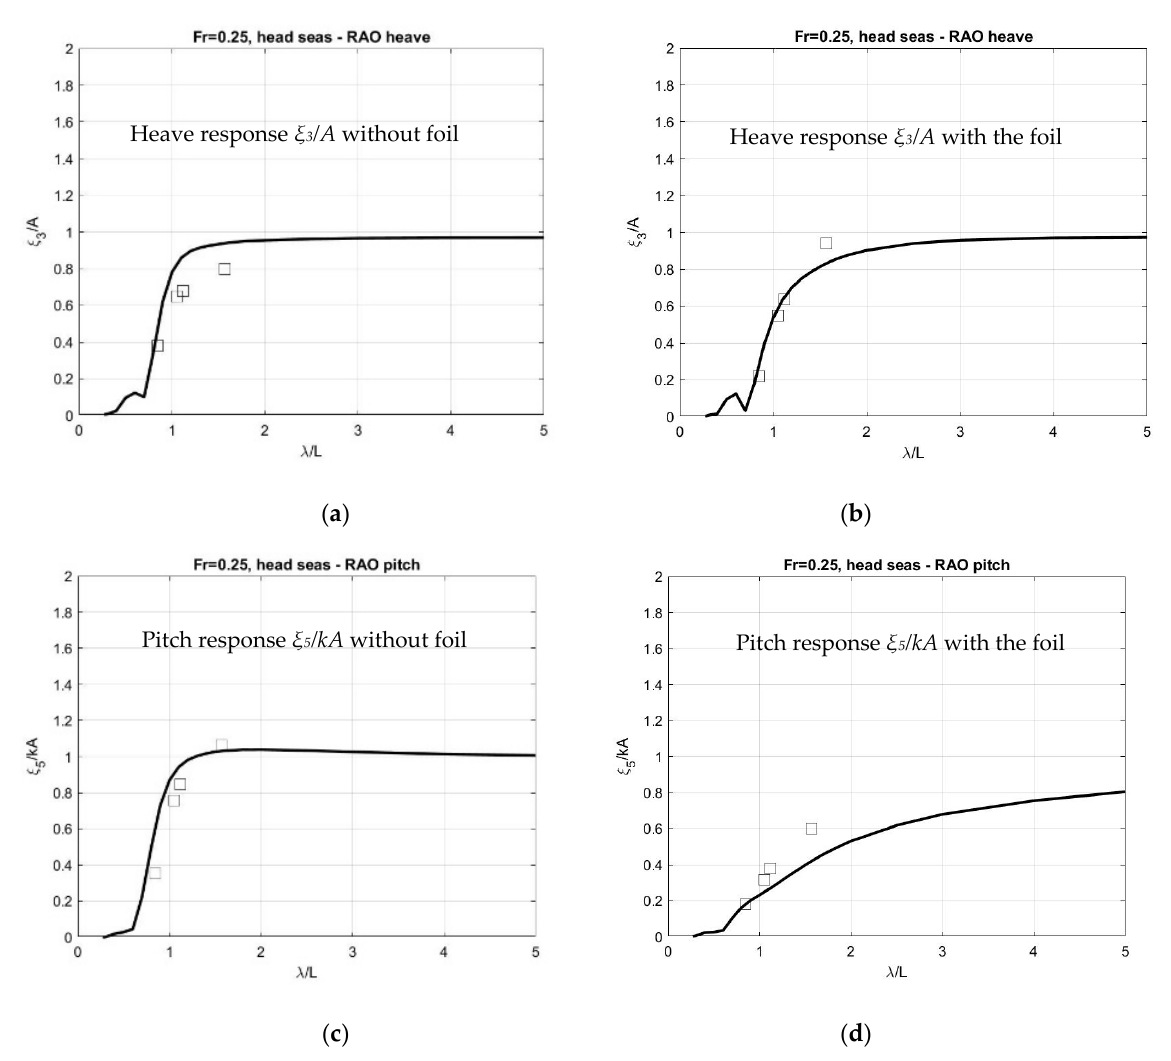
Figure 9. Calculated (lines) and measured (symbols) heave and pitch responses in head waves, with and without the operation of the dynamic foil, for Froude number Fr = 0.25 and the smaller draft. ( a , b ) Heave response without and with the foil, respectively. ( c , d ) Pitch response without and with the foil, respectively.